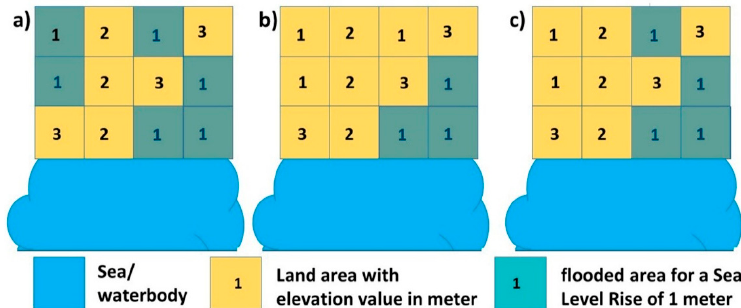
Figure 2. Different bathtub approaches: ( a ) zero-connectivity rule which shows that all the cells in the raster having elevation value ≤ 1 m are flooded; ( b ) four-way hydrological connectivity rule for 1 m SLR where a cell is flooded only if it is connected to a water body directly or via adjacent cells in cardinal directions; and ( c ) eight-way hydrological connectivity rule for 1 m SLR where a cell is flooded only if it is connected to a water body directly or via adjacent cells in either cardinal or diagonal directions.